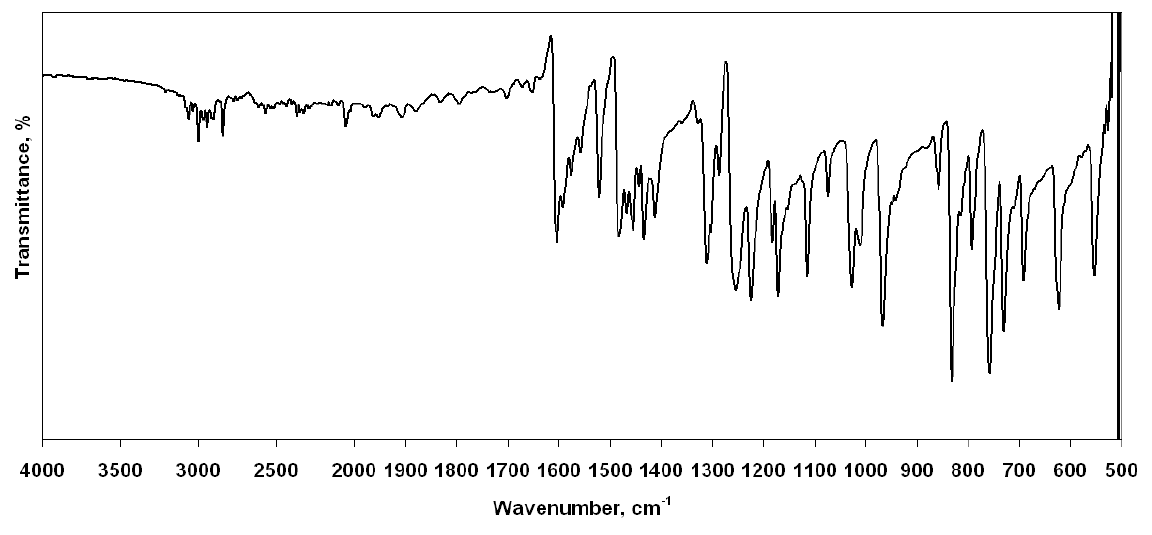
Figure 2. FT-IR spectrum of 2-(4-methoxyphenyl)benzo[d]thiazole recorded at room